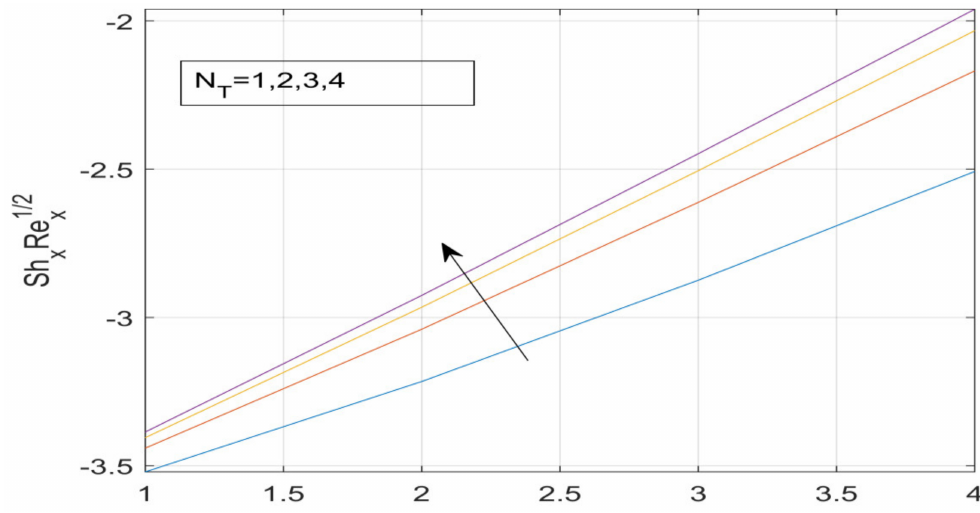
Figure 26. Effect of N_T of on − ψ ˆ (cid:48)